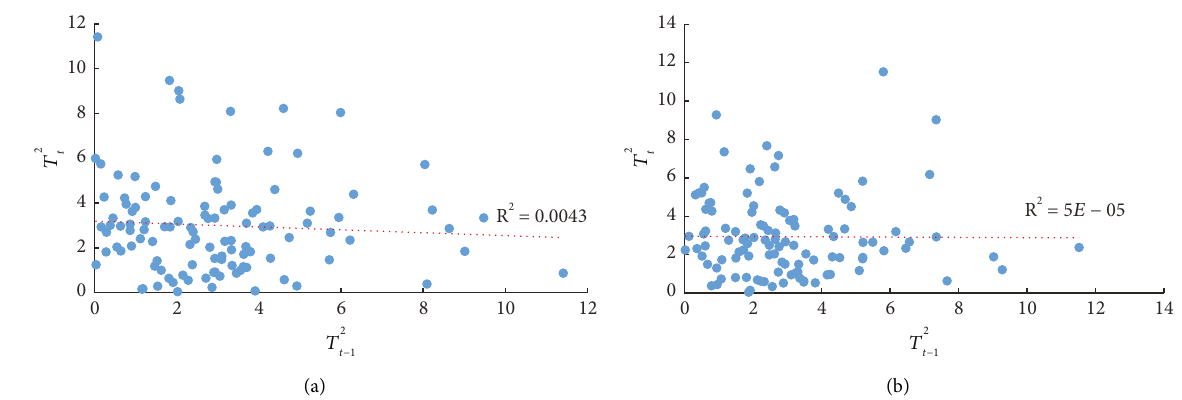
Figure 5: Randomness of T 2 statistics based on the residuals issued from (a) ARIMA and (b) LR models.